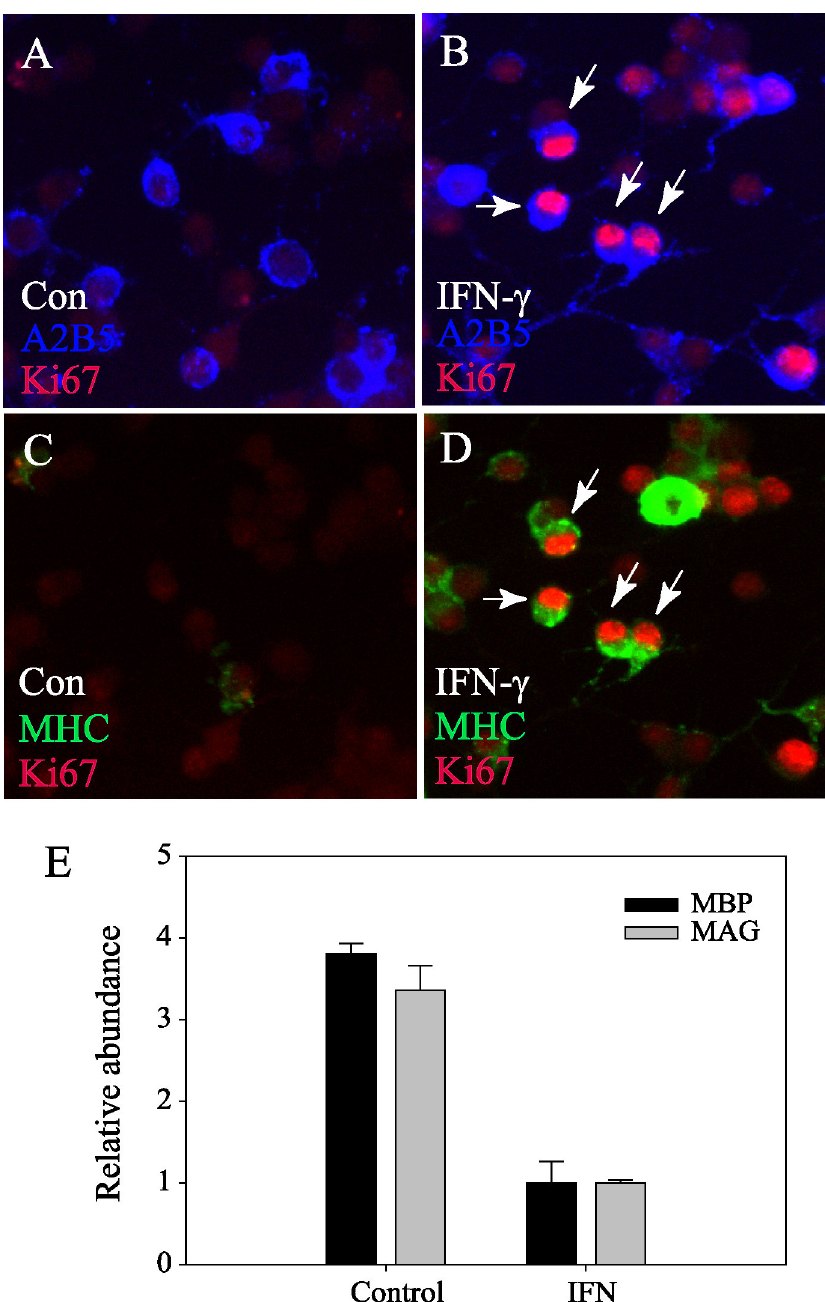
FIGURE 1. Effects of IFN- γ on proliferation, MHC, and myelin gene expression in differentiating OPCs in culture. (A–D) IFN-induced MHC expression is colocalized with cell cycle marker Ki67 in A2B5+ OPCs. Triple immunofluorescent labeling of OPCs maintained in culture with 30 ng/ml thyroid hormone (T3) for 4 days in the absence (A,C) and presence (B,D) of 15 ng/ml rat IFN- γ . Dual-labeled cells are shown in pairs, with A,B showing Ki67 (red) and A2B5 (blue) labeling, while C,D show Ki67 and MHC I (green). Ox18 labels conserved parts of the heavy chain regardless of MHC haplotype. White arrows indicate triply labeled A2B5+, MHC+, and Ki67+ cells. Magnification × 400. (E) Reverse transcription-quantitative (RT-qPCR) PCR analysis of total RNA for myelin basic protein (MBP) and myelin-associated glycoprotein (MAG) from OPCs cultured in the absence (control) and presence (IFN) of 15 ng/ml IFN- γ for 3 days in